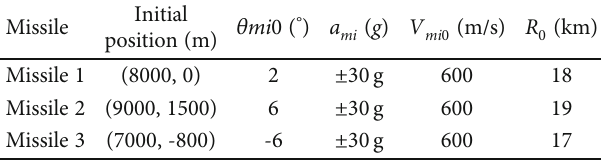
Table 1: Simulation conditions for